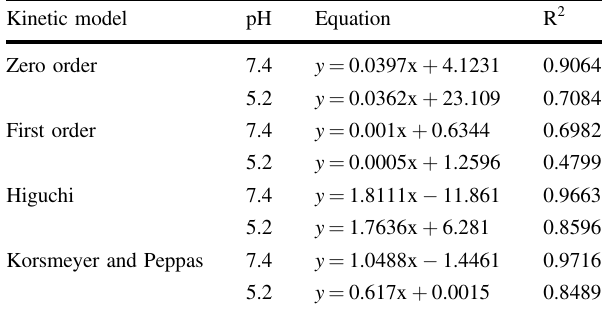
Fig. 5 Pro fi les of different kinetic models for release of PTX from pH-responsive PTX/ niosome in PBS solution with different pH levels of 5.2, and 7.4 at 37 °C